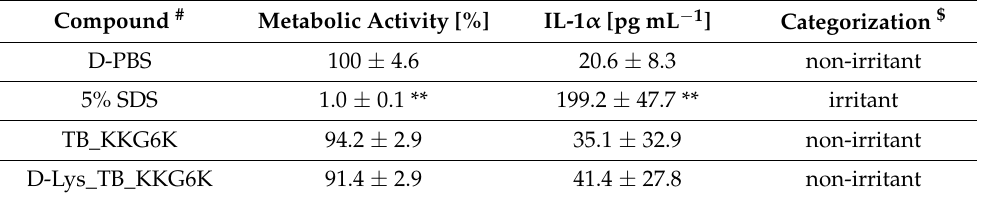
Table 5. Cellular metabolic activity of the in vitro 3D Phenion ® OS-REp model and release of proinflammatory cytokine IL-1 α in response to the treatment with the TB peptide analogs. Compound # Metabolic Activity [%] IL-1 α [pg mL − 1 ] D-PBS TB_KKG6K D-Lys_TB_KKG6K # The peptides (50 µ g) were applied in 25 µ L aliquots per model. Values of metabolic activity after peptide treatment were calculated by comparison with the D-PBS treated model (negative irritation control), which was assigned 100% metabolic activity. SDS (5%, w / v ) was used as a positive irritation control (inhibition of metabolic activity). Metabolic activity and IL-1 α values represent the mean ± SD (n = 3). $ Irritant categorization threshold ≤ 50% metabolic activity compared to the negative control [24]. Significant differences in IL-1 α release